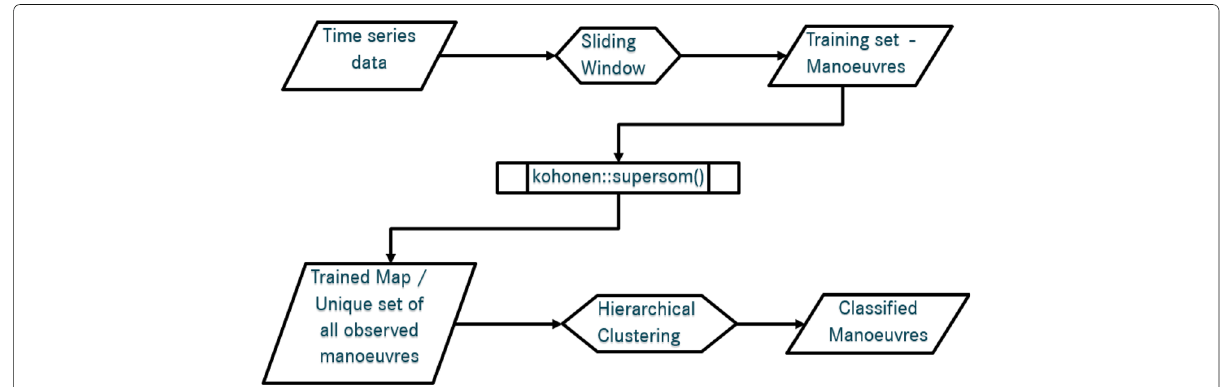
Fig. 1 Training Phase. Modelling and Classification of Manoeuvres